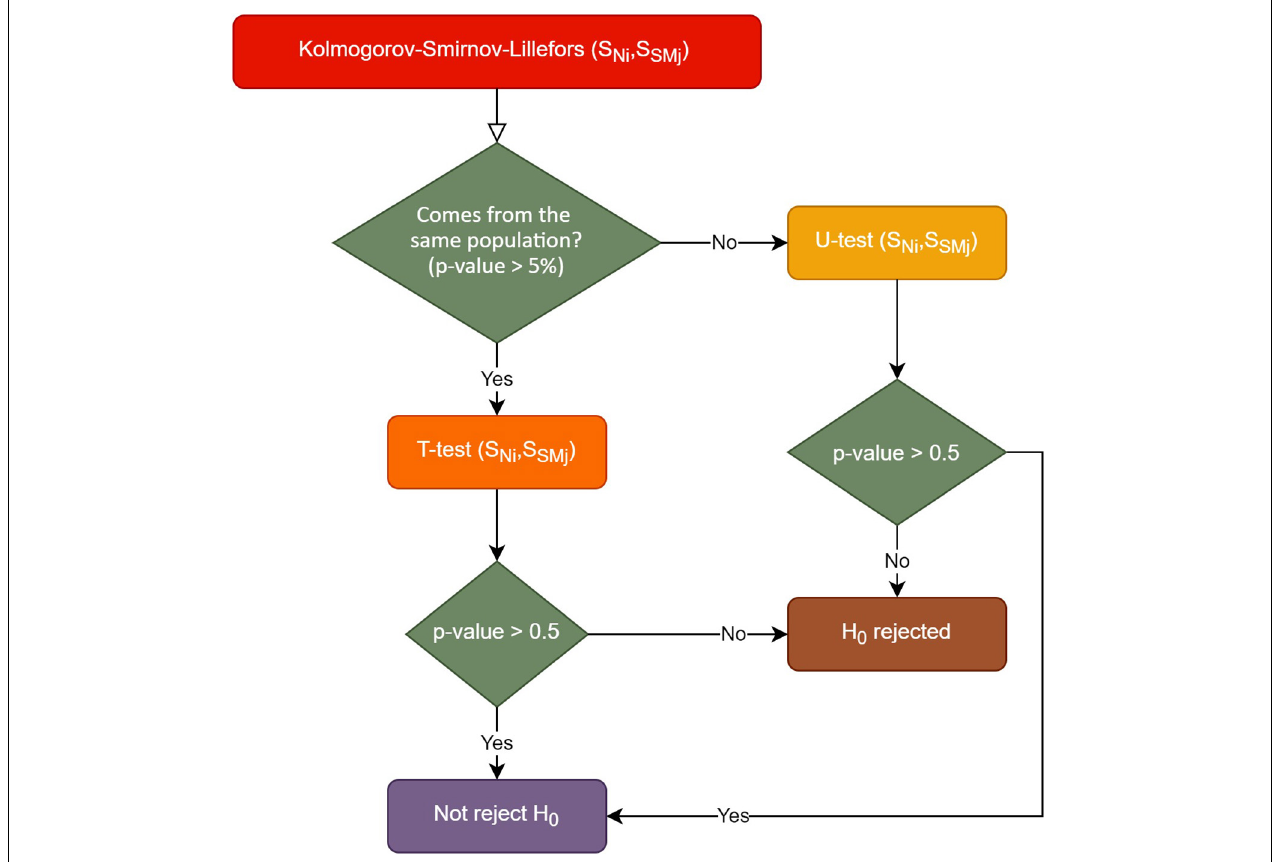
FIGURE 3 | Statistical analysis according to the test rules used.